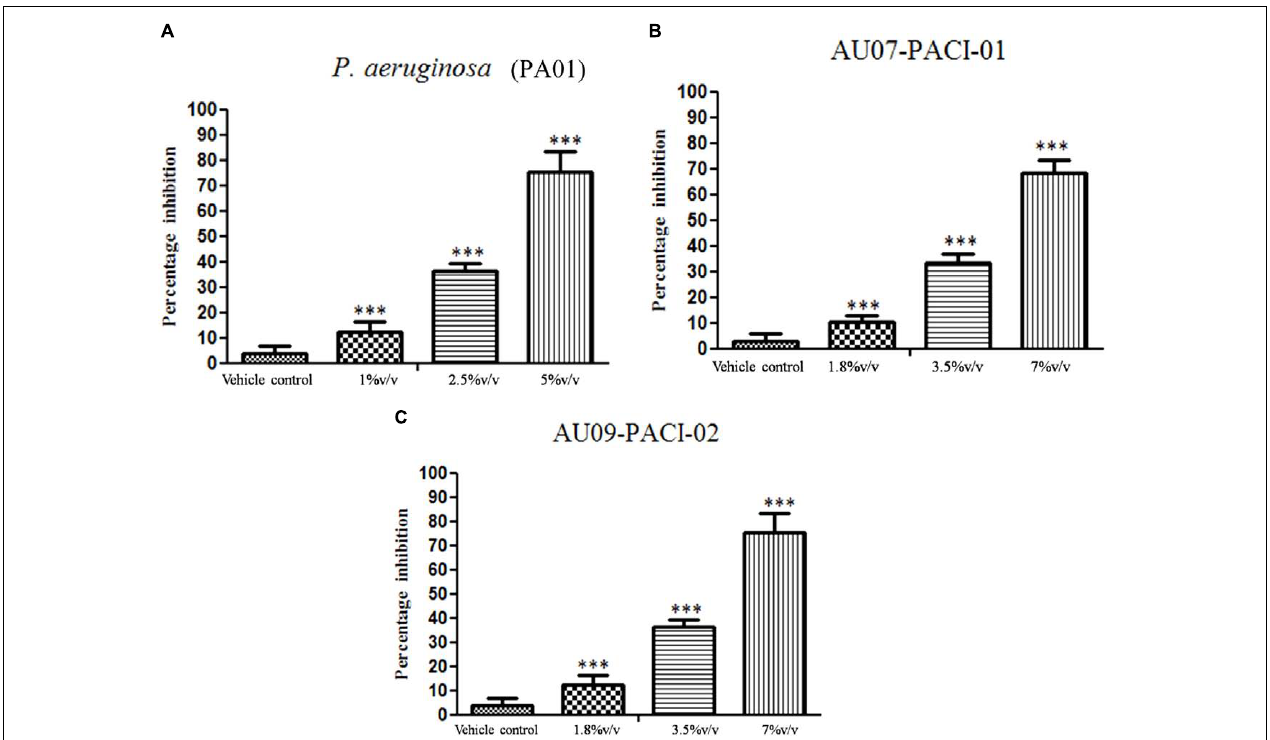
FIGURE 10 | Inhibition of staphylolytic activity (A) P. aeruginosa biofilm by EO treated (1–5% v/v), (B) AU07-PACI-01 biofilm in the presence of EO (1.8–7% v/v), (C) AU09-PACI-02 biofilm in the presence of EO (1.8–7% v/v). Mean values of triplicate independent experiments ± SD are shown. One-way ANOVA test demonstrates significant difference between the control and the test. Single asterisk indicates significant at P ≤ 0.025 and triple asterisk indicates significant at P ≤ 0.005.